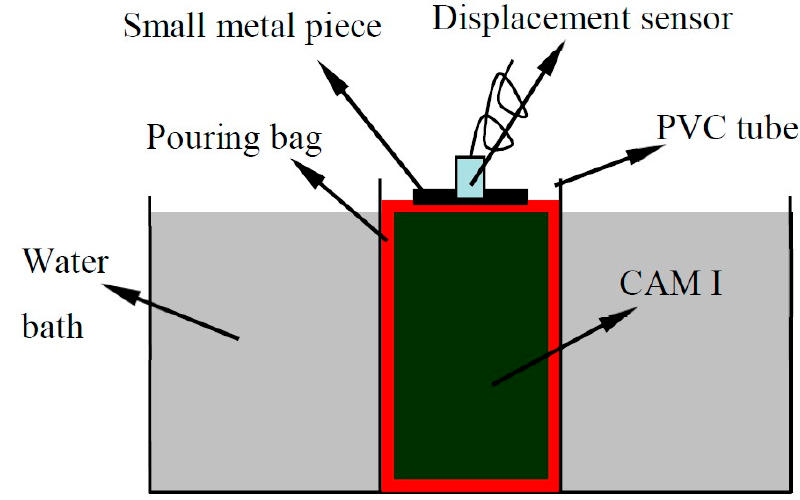
Figure 4. Testing device of the early expansion ratio of CAM I.